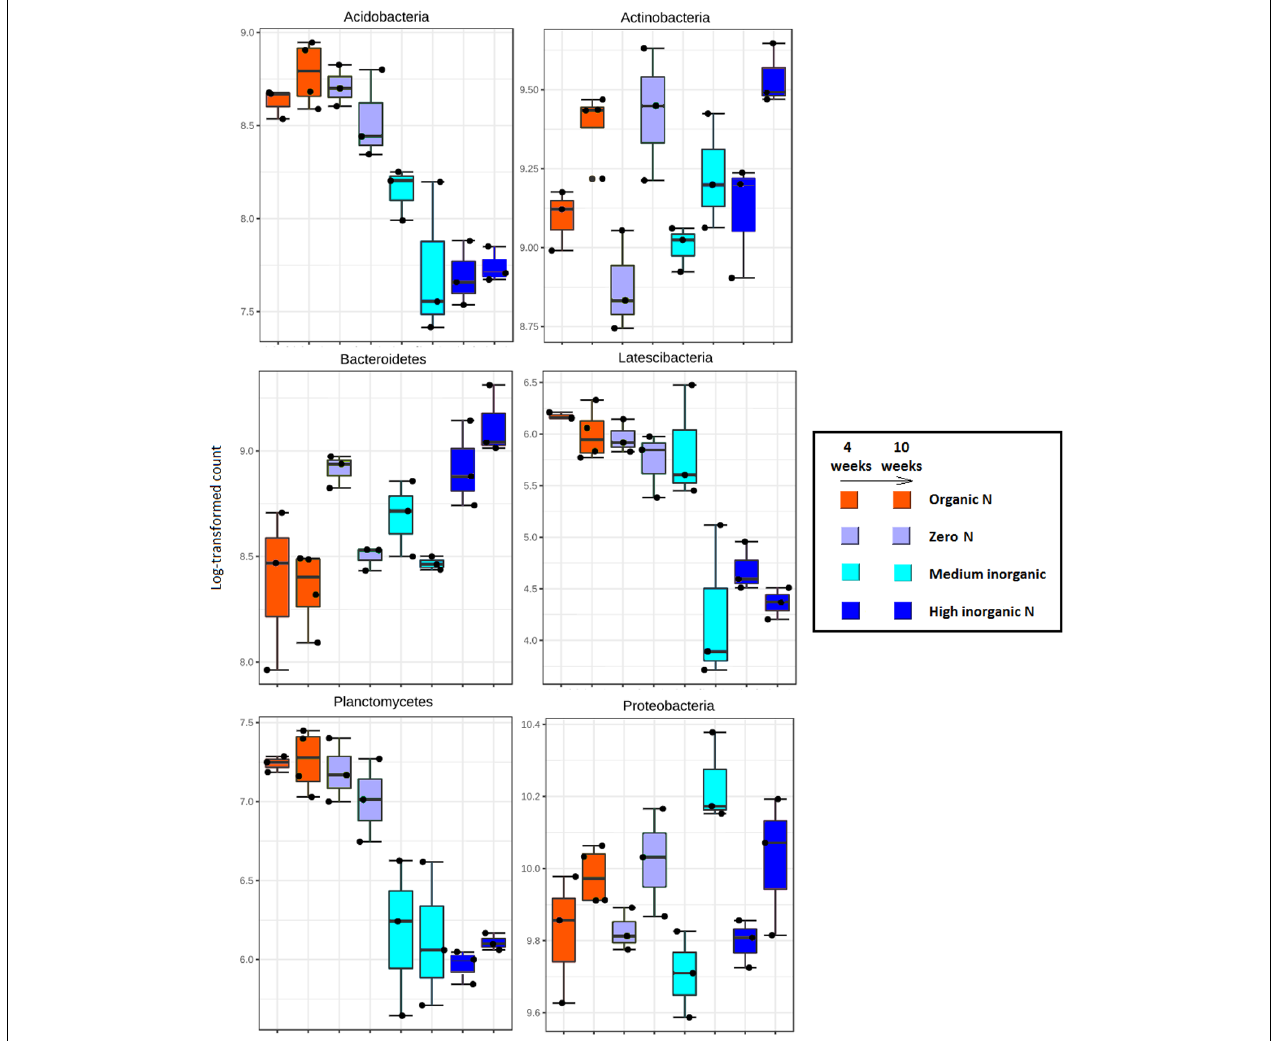
FIGURE 4 | Extended error plots showing the proportion of sequences (%) that were statistically different ( p < 0.01) for the major bacterial phyla (relative abundance > 1% for most of the samples) obtained from rhizosphere of wheat grown in soils under different fertilization regime (organic N, zero N, medium inorganic N, high inorganic N), collected at two stages: 4 weeks and 10 weeks. Each treatment is represented by bars with the same colors and they occur in pairs, with samples collected after 4 weeks on the left and samples collected after 10 weeks on the